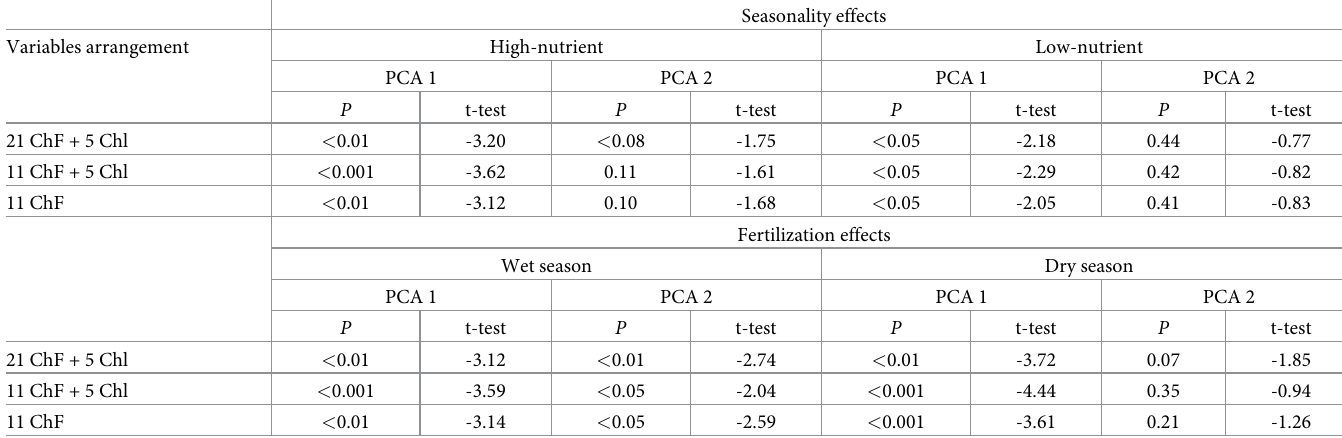
Table 2. Effects of seasonality and fertilization with 21 and 11 ChF and 5 photosynthetic pigment